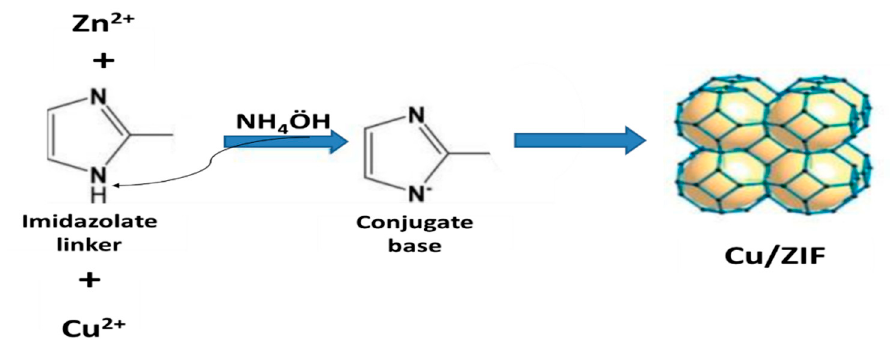
Figure A1. Schematic representation for construction of Cu-based ZIF catalyst.